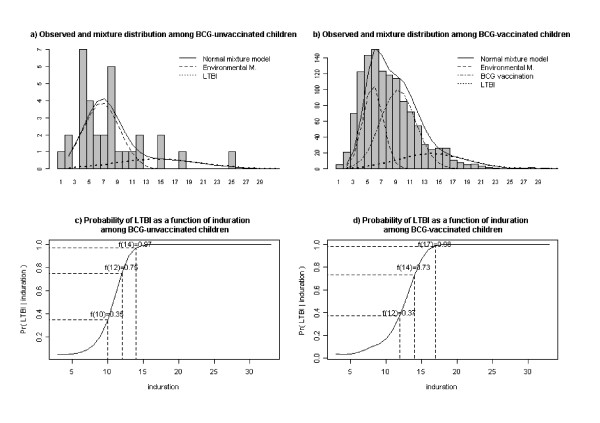
Induration distribution after tuberculin test and probability of LTBI as a function of induration diameter (mm) among unvaccinated children (on the left) and BCG-vaccinated children (on the right)